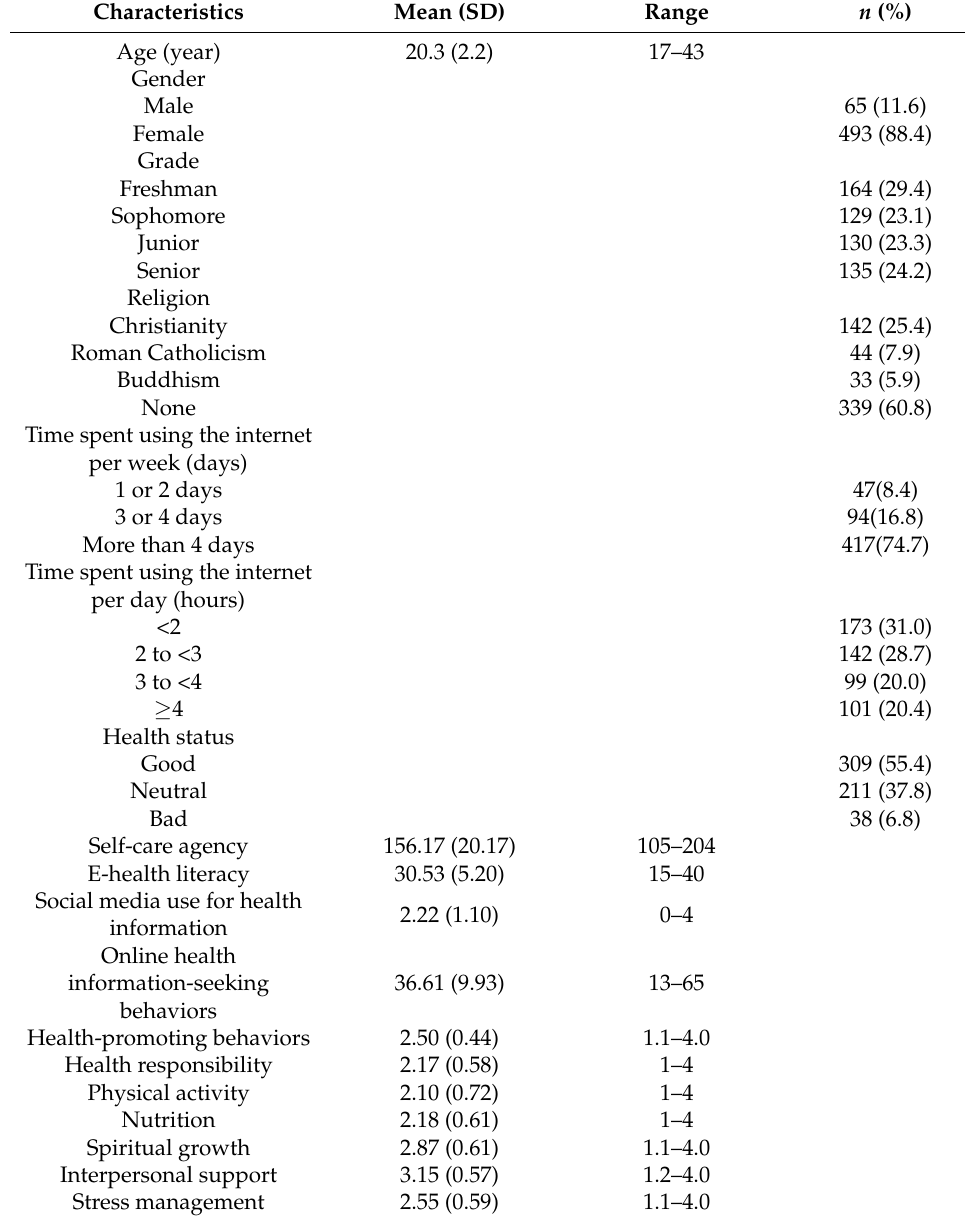
Table 1. Descriptive Statistics ( n =